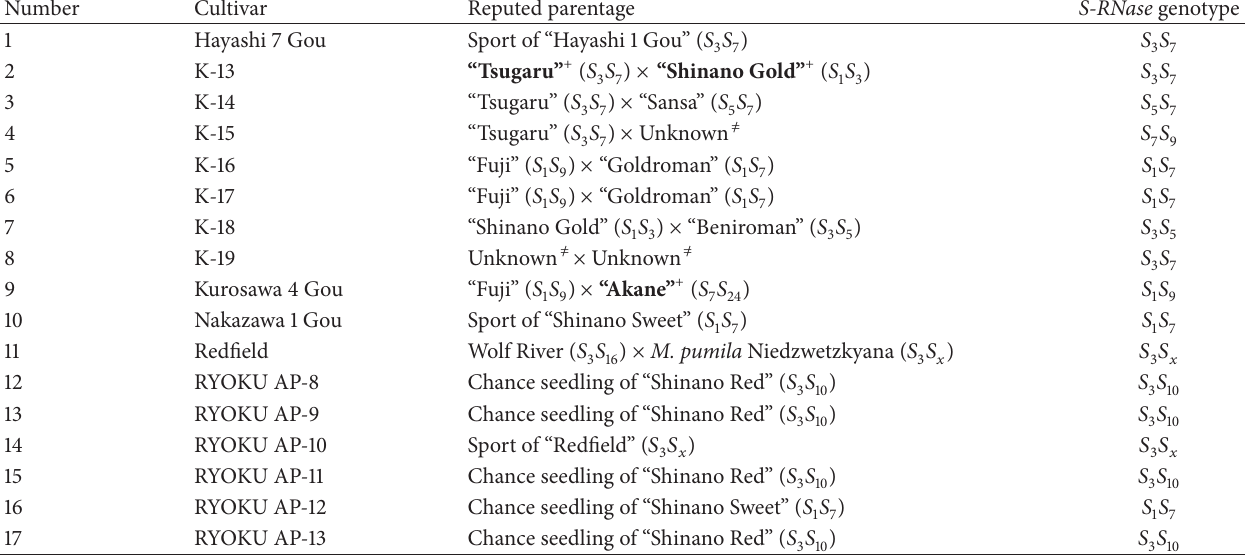
Table 1: S-RNase genotypes of 17 new apple cultivars including their